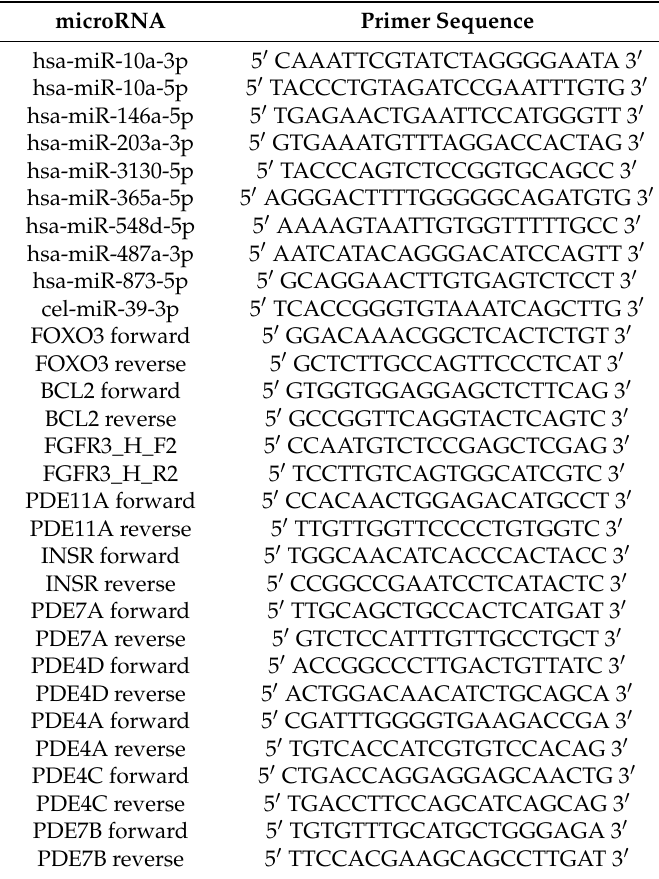
Table A2. The target sequences of primers used in this